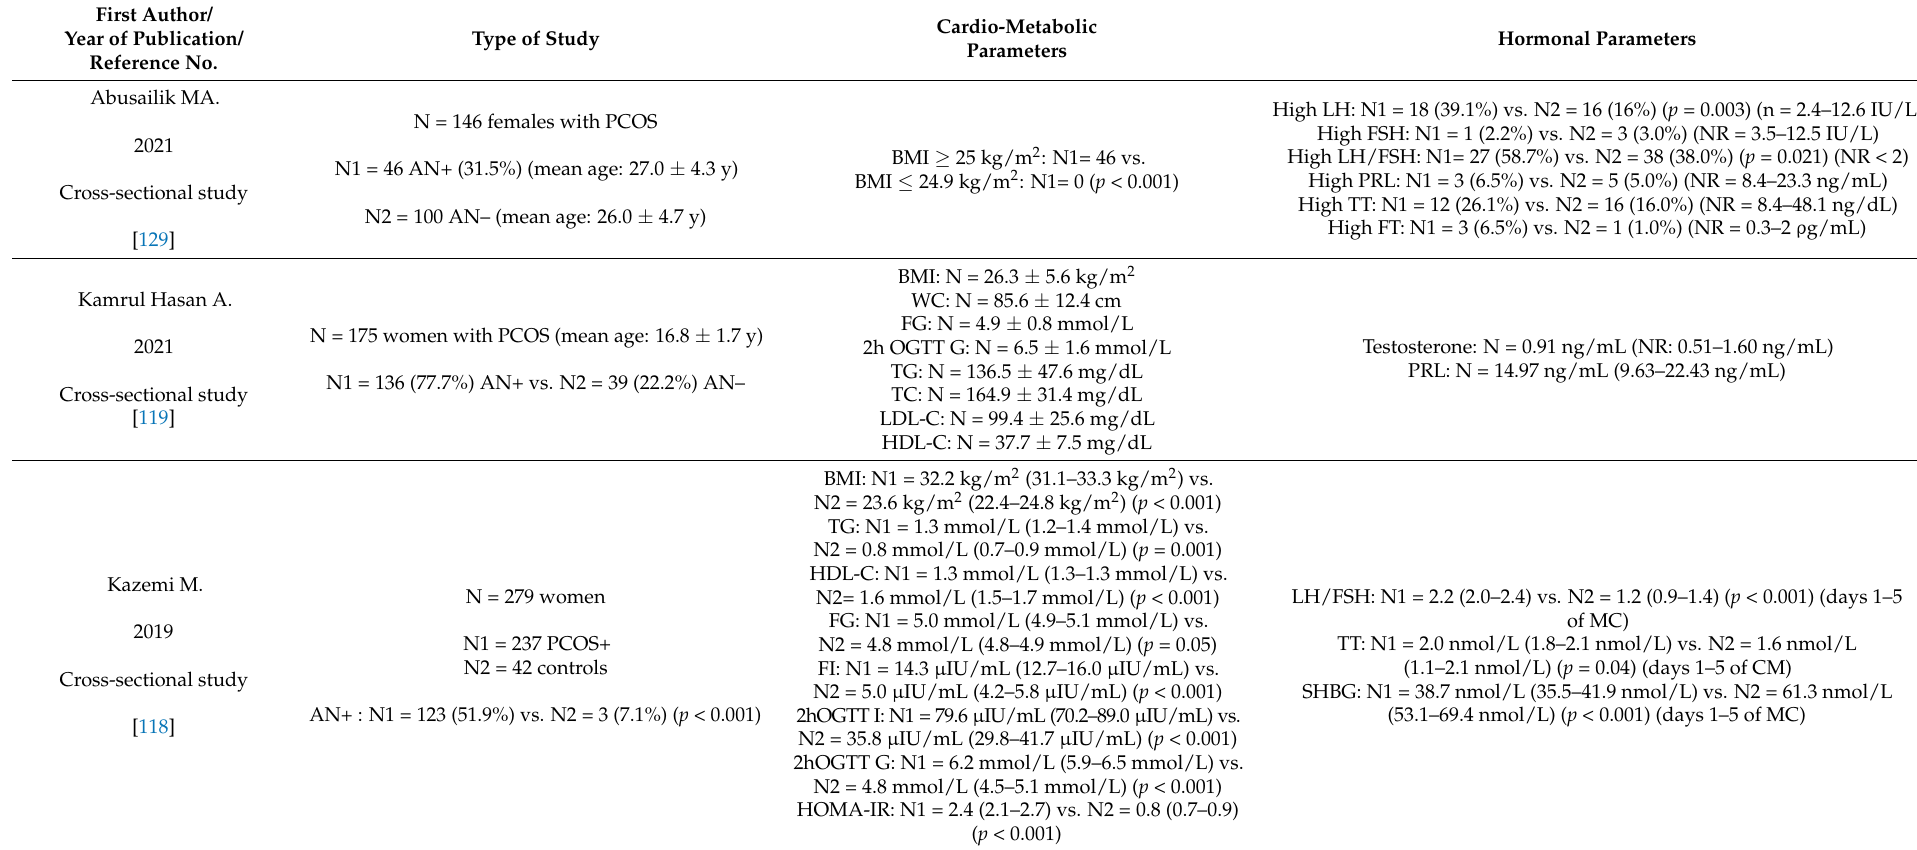
Table 3. Studies within the last 5 years concerning AN and PCOS (the order of display is from 2022 to 2017) (please see references no.